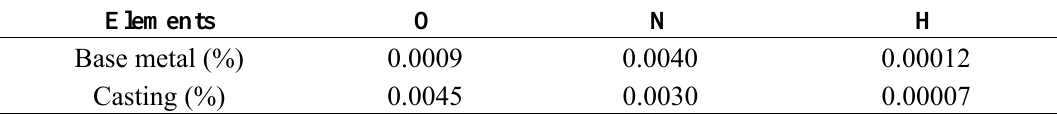
Table 3. Gas content of the base metal and the